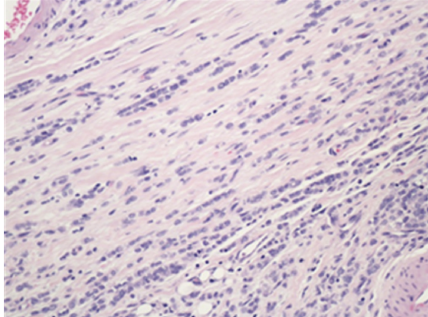
Figure 2: High power light microscopy image of metastatic cells showing the classical appearance of lobular carcinoma of the breast with discohesive cells forming an “Indian file.”